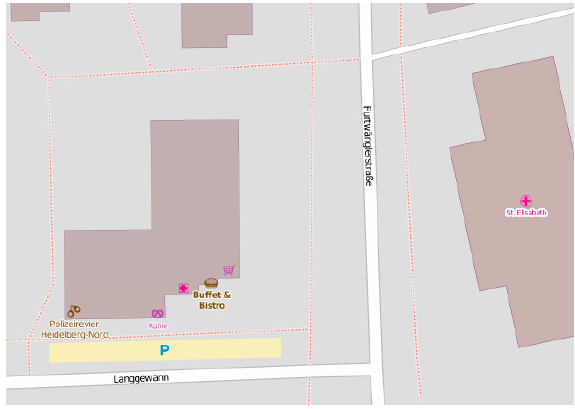
Figure 4. Footways are displayed as dotted lines but entry points of footways are not easy to identify. To start with, the entity “footway entry point” and its relations with other types of entities in OSM have to be modeled to support the reasoning process. For this scenario, we have developed the